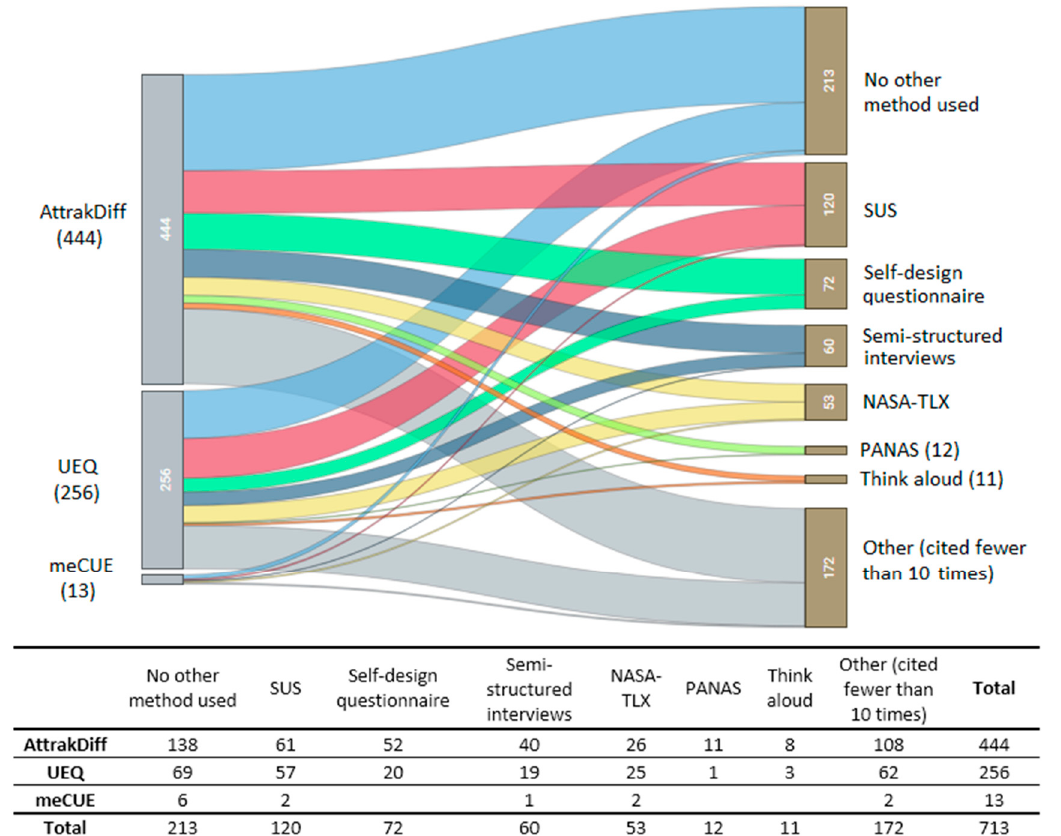
Figure 6. Additional methods used in combination with the three standardized